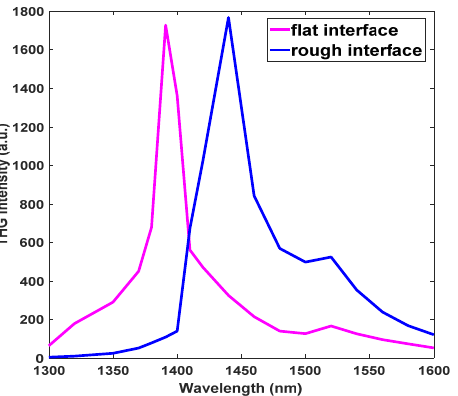
Figure 9. The function of the THG signal and excitation wavelength of the coupled structure.